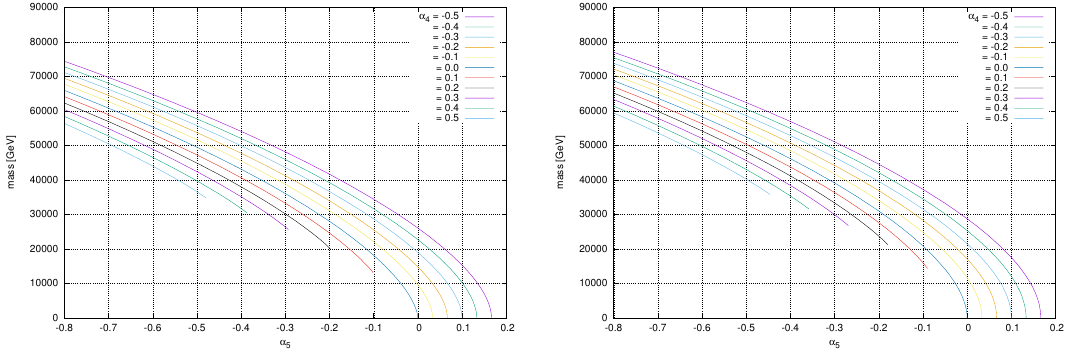
Figure 6 . Mass of the EW-Skyrmion as functions of (cid:11) 5 for various choices of (cid:11) 4 for the cases of ( a; b; c ) = (1 ; 0 : 8 ; 0) (left panel) and ( a; b; c ) = (1 ; 1 : 2 ; 0) (right